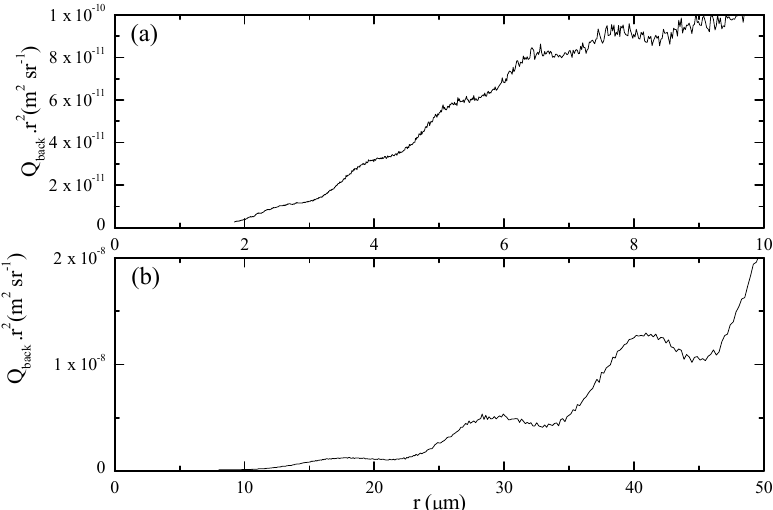
Figure 7. Simulations of the single-particle backscattering coefficient as a function of particle radius for lignite particles. Simulations consider a log-normal size distribution with a percentage standard deviation of 5%. (a) Selection of a minimum radius of 1.84µm, as given by Civiš and Hovorka (2010) and a maximum radius of 10µm; (b) selection of a minimum radius of 8µm, as given by Triantafyllou et al. (2006) and a maximum radius of 50µm. Both simulations consider a sounding wavelength of 1.064µm.